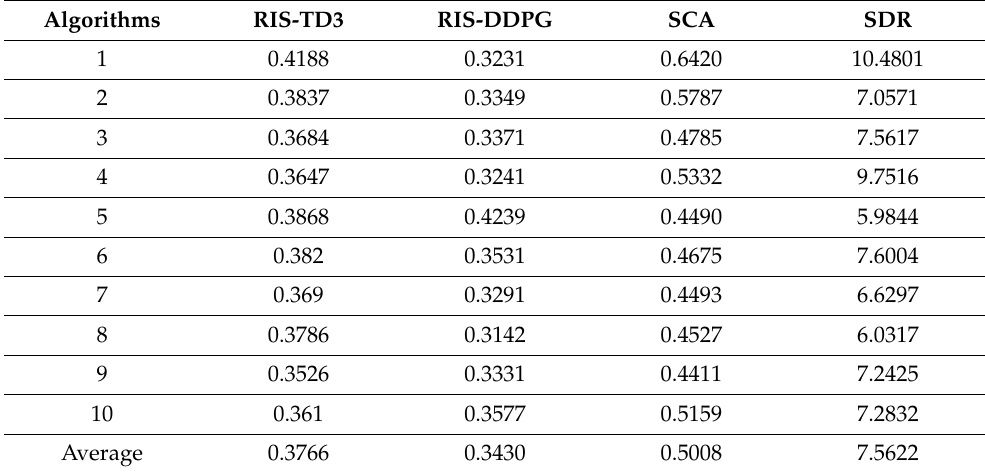
Table 2. Time consumed of various algorithms at N = 36 (unit: second). Algorithms